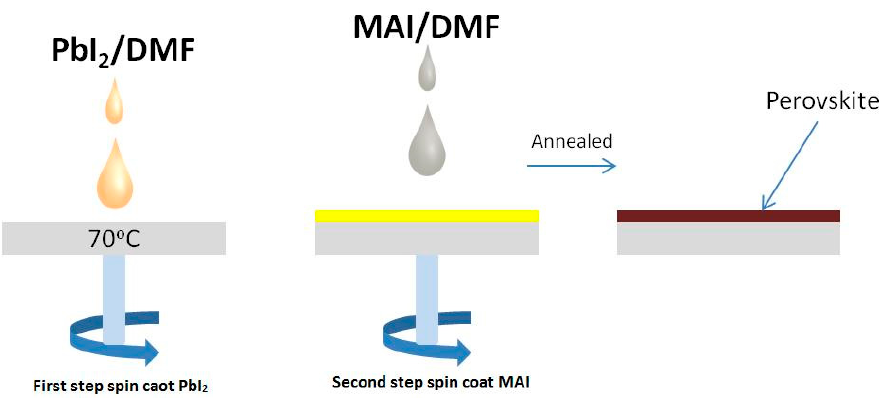
Figure 6. Schematic illustration of two-step solution processing method. Reprinted with permission from Ref [64]. Copyright (2020) Elsevier.